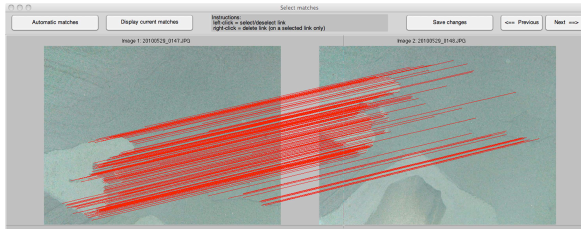
Fig. 3. The interface of the match selector allows the end user the ability to browse through each pair of images and visualize the com- puted matches; erroneous matches can be removed and new matches can be manually created.